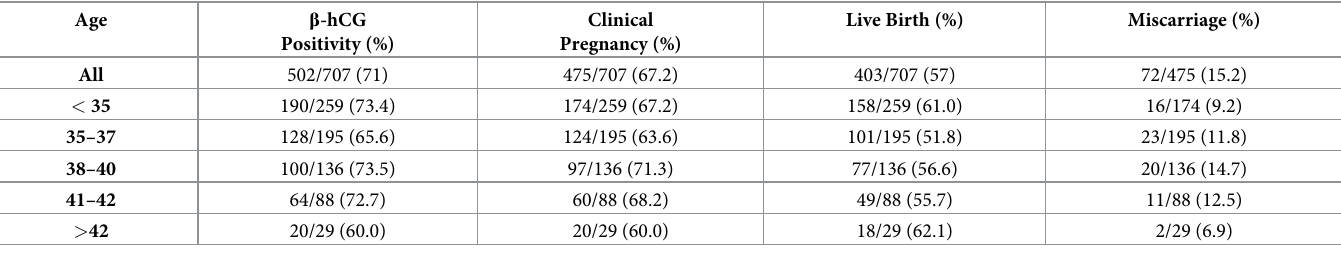
Table 1. Pregnancy outcomes for single euploid embryo transfers stratified by maternal